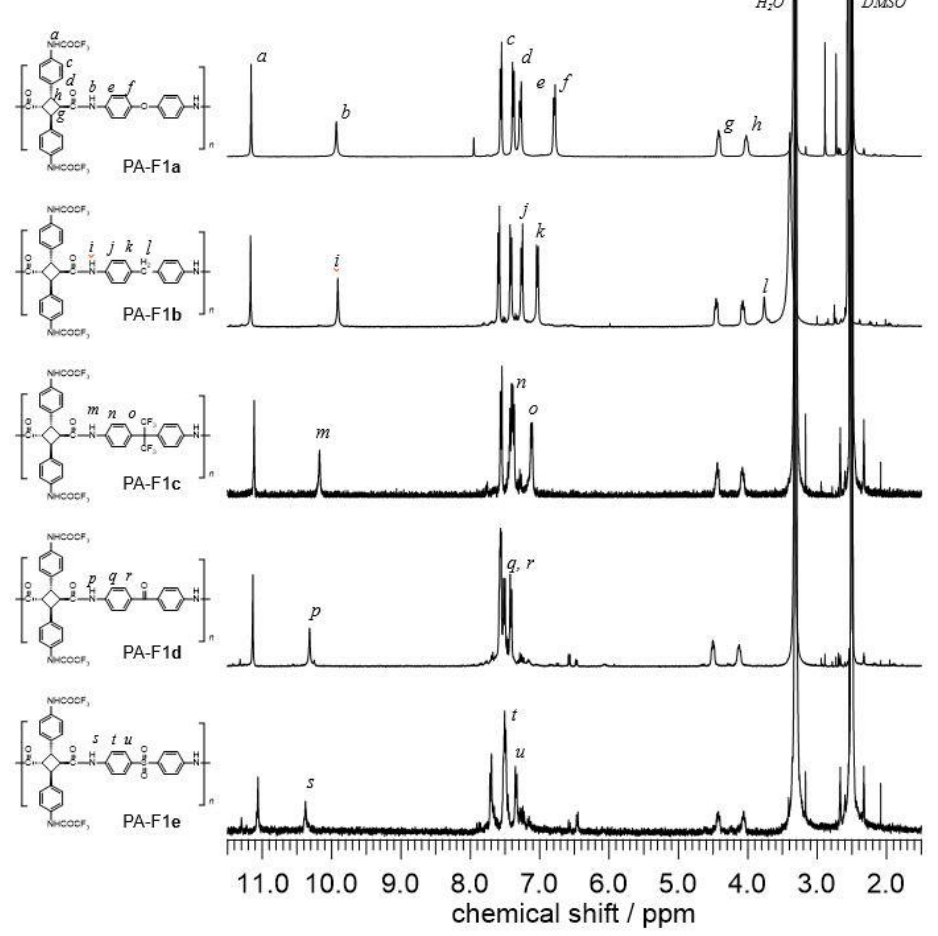
Figure 3. 1 H NMR spectra of the PA-F1 a , PA-F1 b , PA-F1 c , PA-F1 d , and PA-F1 e (Solvent, DMSO- d 6